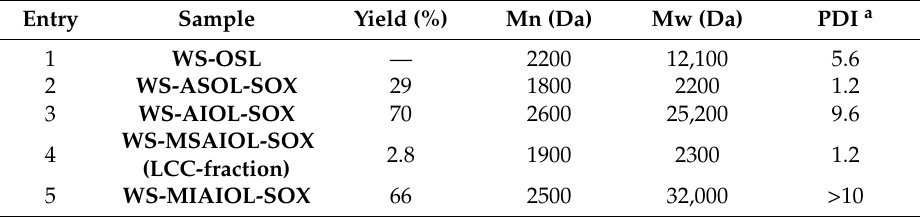
Table 1. Yields and molecular mass key characteristics of WS-OSL and Soxhlet-derived fractions.